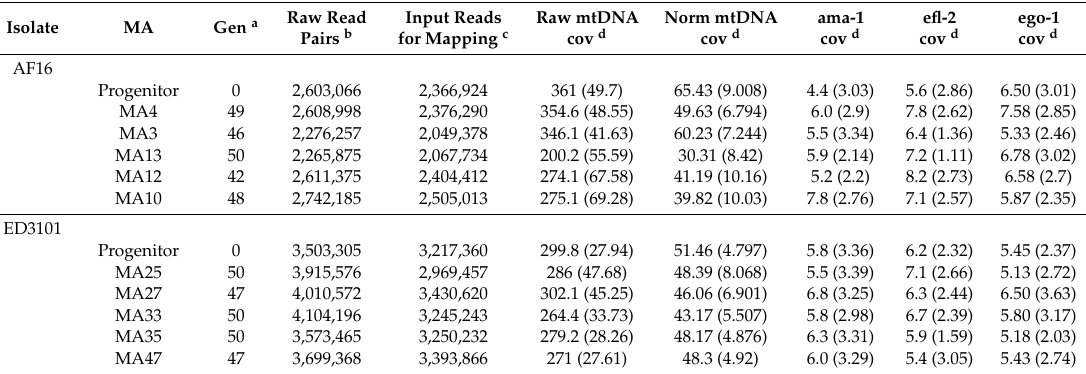
Table 1. C. briggsae isolates and MA lines used for Illumina DNA